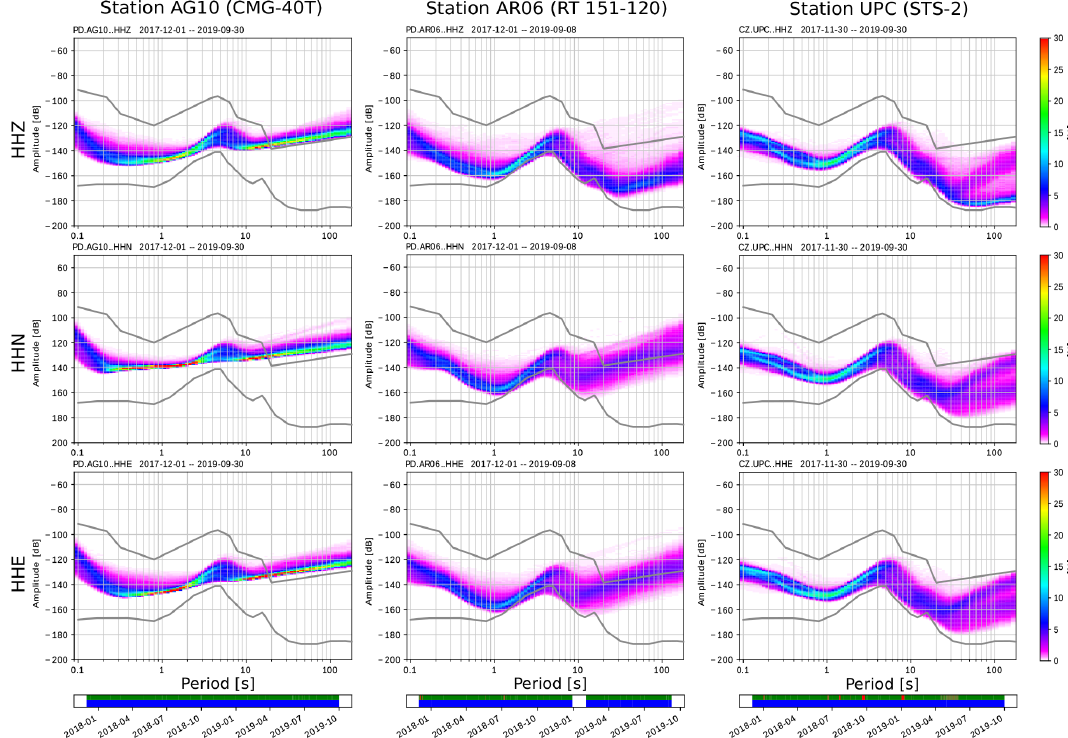
Figure 11. Probabilistic power spectral density (PPSD) for stations AG10 (CMG-6T), AR06 (RT 151–120) and permanent station UPC (STS- 2). The Z , N and E components at the top, middle and bottom, respectively. The time span for calculation is 22 months (from January 2018 to October 2019). Black lines mark new high and low noise models (NHNM, NLNM; Peterson,